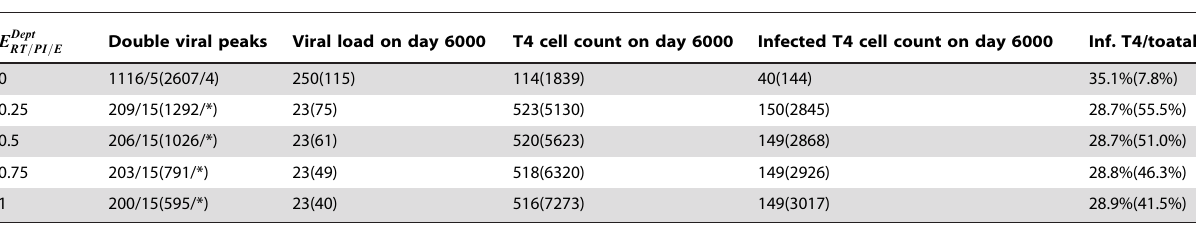
Table 3. Simulation of different levels of drug effectiveness in different